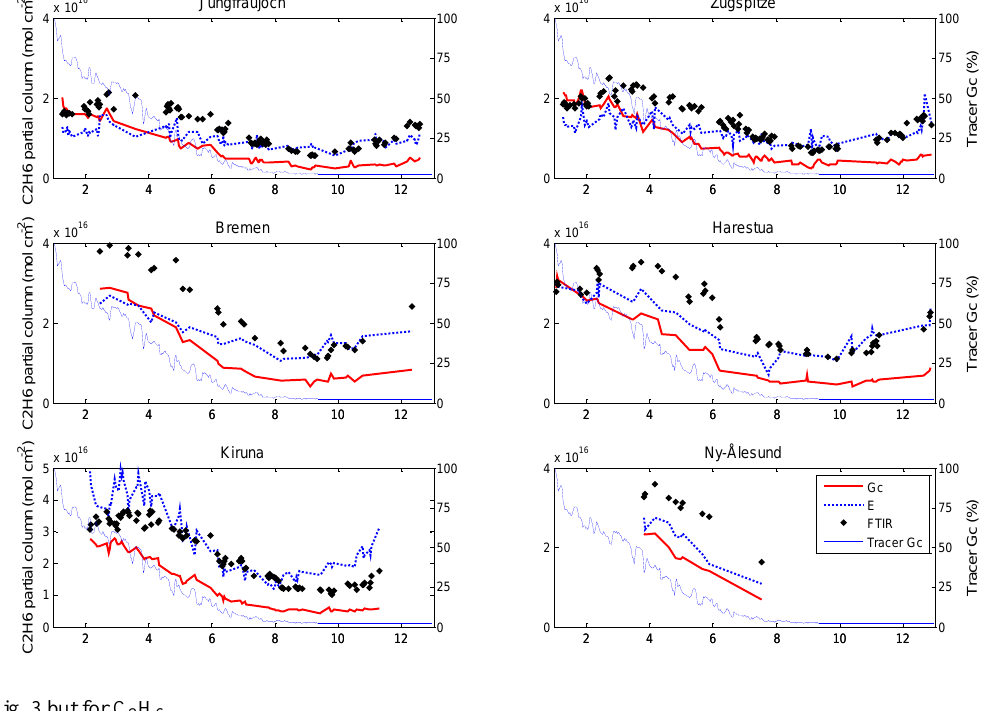
Figure 4. As in Figure 3 but for C